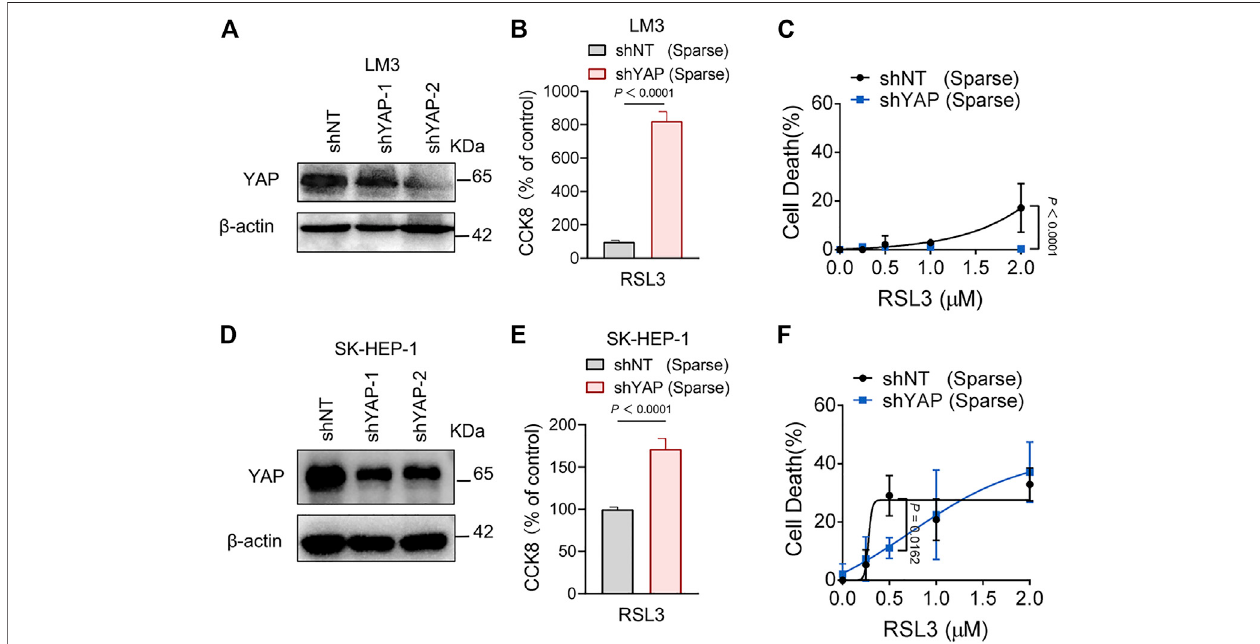
FIGURE 5 | Knockdown of YAP inhibits ferroptosis in HCC cells. (A) LM3 were infected with shYAP-1 or shYAP-2 lentivirus and selected with puromycin. Knockdown ef fi ciency was con fi rmed by western blot. (B) Sparse LM3 cells expressing shNT or shYAP as indicated were treated with 2 µM RSL3. Cell viability was determined using the Cell Counting Kit 8 (CCK8). n (cid:2) 5 biologically independent samples per condition. (C) Sparse LM3 cells expressing shNT or shYAP were treated with RSL3 with indicated concentrations and cell death was measured. n (cid:2) 3 biologically independent samples per condition. (D) Knockdown ef fi ciency of YAP in SK-HEP-1 cells was con fi rmed by western blot. (E) Sparse SK-HEP-1 cells expressing shNT or shYAP were treated with 1 µM RSL3 and cell viability was determined with CCK8. n (cid:2) 7 biologically independent samples per condition. (F) Sparse SK-HEP-1 cells expressing shNT or shYAP were treated with RSL3 and cell death was measured. n (cid:2) 3 biologically independent samples per